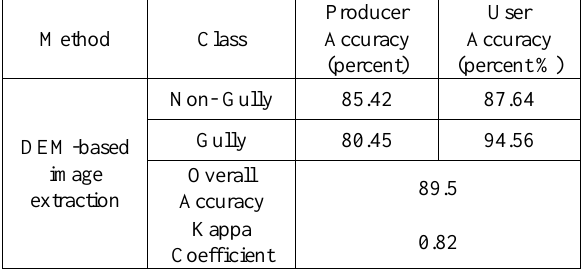
Table 5. The results of accuracy assessment of heuristic